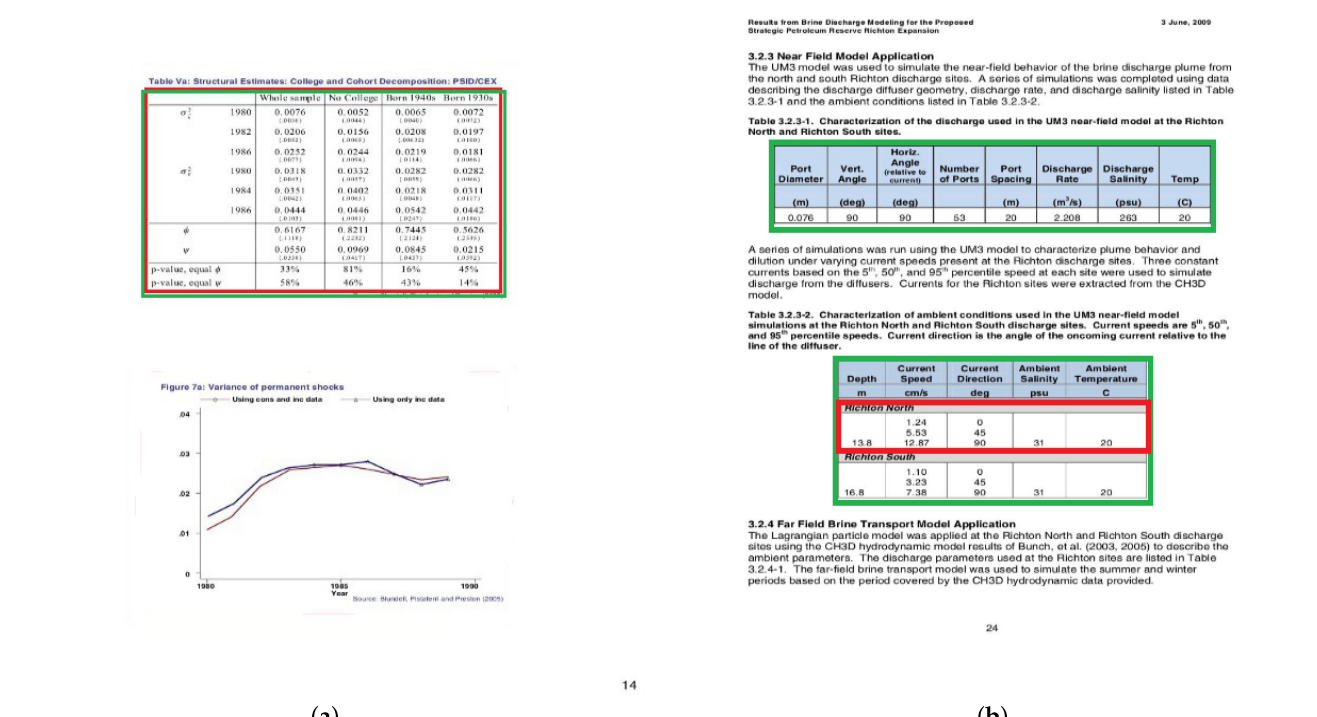
Figure 6. Some sample images from ICDAR 2017-POD showing: ( a ) True Positive, ( b ) false positive. The green region represents the ground truth bounding boxes while red region represents bounding boxes of detected regions.